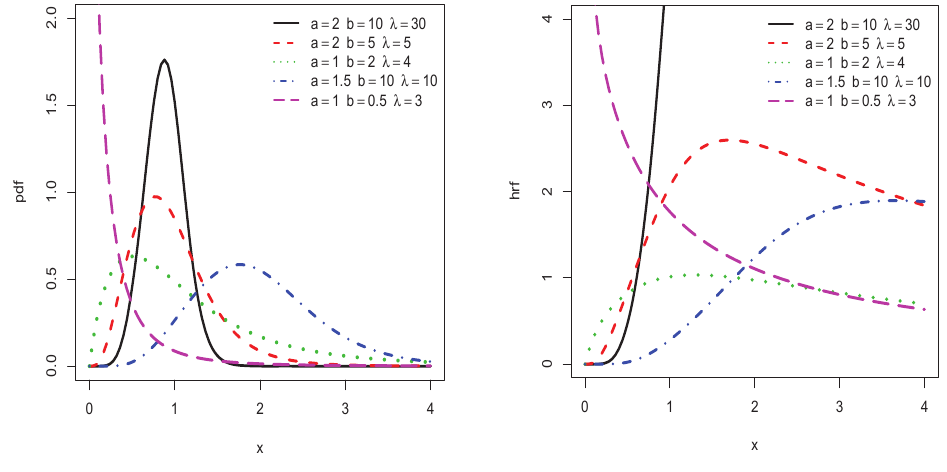
Figure 2. Plots of some pdfs and hrfs of the TIHLIK